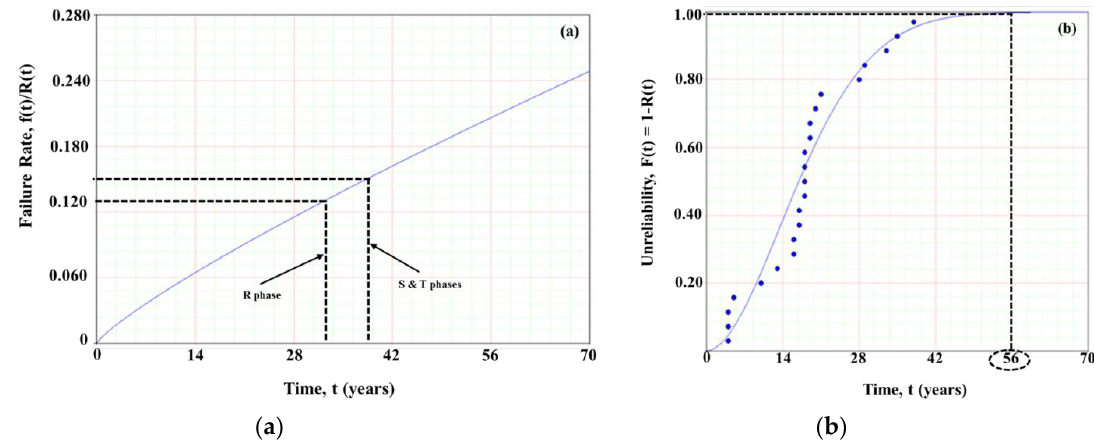
Figure 9. Estimation of effective age of PTs using failure distribution curves ( a ) failure rate versus time ( b ) unreliability versus time.